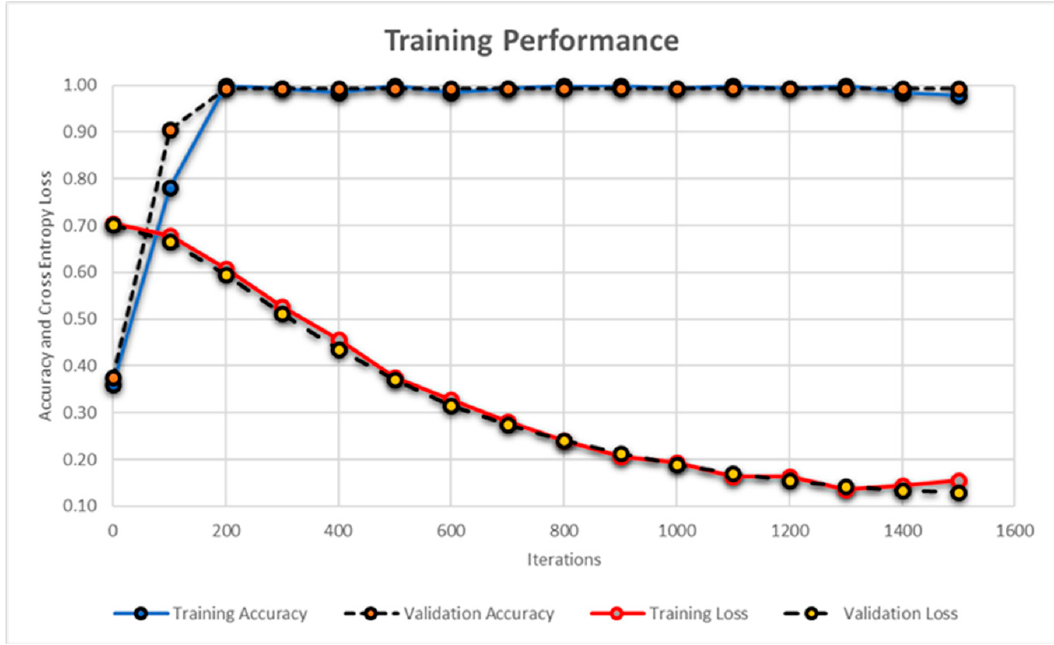
Figure 17. Training performance of the proposed CNN model. Blue line shows the training accuracy, red line shows the training loss and the dashed black lines shows the validation accuracy and validation loss.